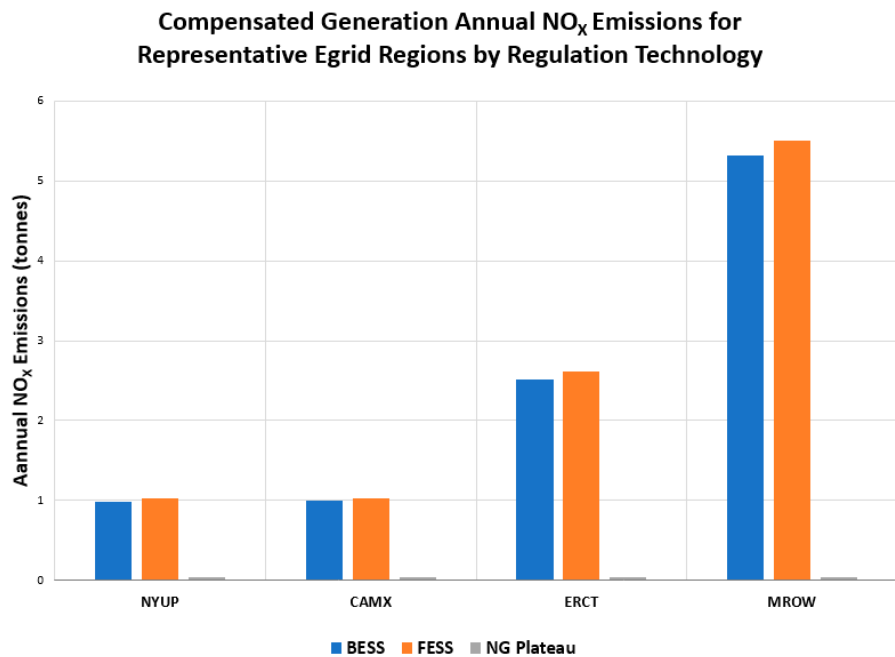
Figure 4. Annual NO X emissions when providing Reg A frequency regulation service with compensated generation for upstate New York (NYUP), California (CAMX), Texas (ERCT), and the upper Midwest (MROW). The BESS and FESS emissions are similar for all regions with the BESS having slightly lower emissions. The compensated generation natural gas plant has significantly lower NO X emissions than the two types of ESS.